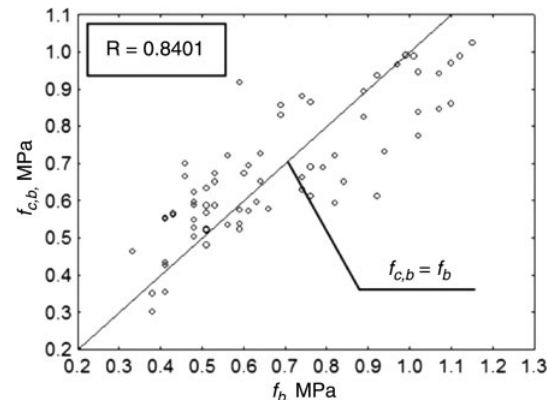
Fig. 14. Dependence between experimentally determined pull-off adhesion f b and pull-off adhesion f c , b identified by neural network during its testing